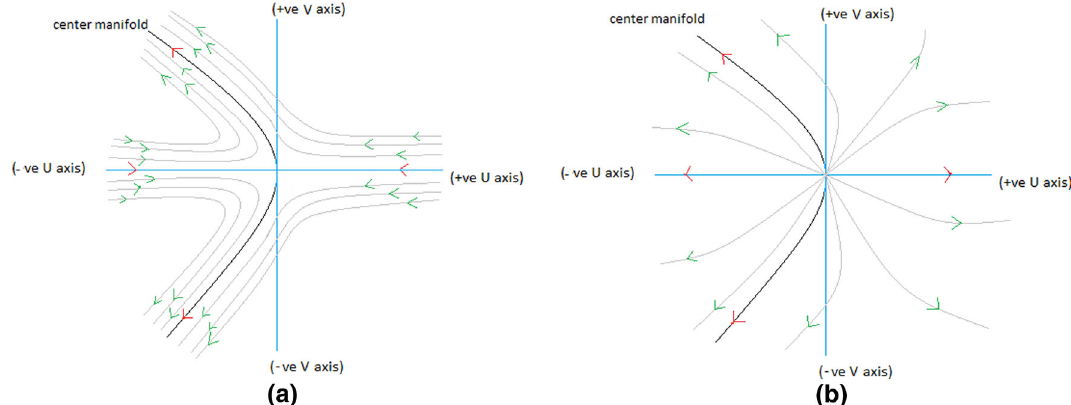
Fig. 8 Vector field near the origin in UV -plane for the critical point P 4 . L.H.S. figure is for ( α < 3 ,μ < 0) and R.H.S. figure is for ( α > 3 ,μ < 0)